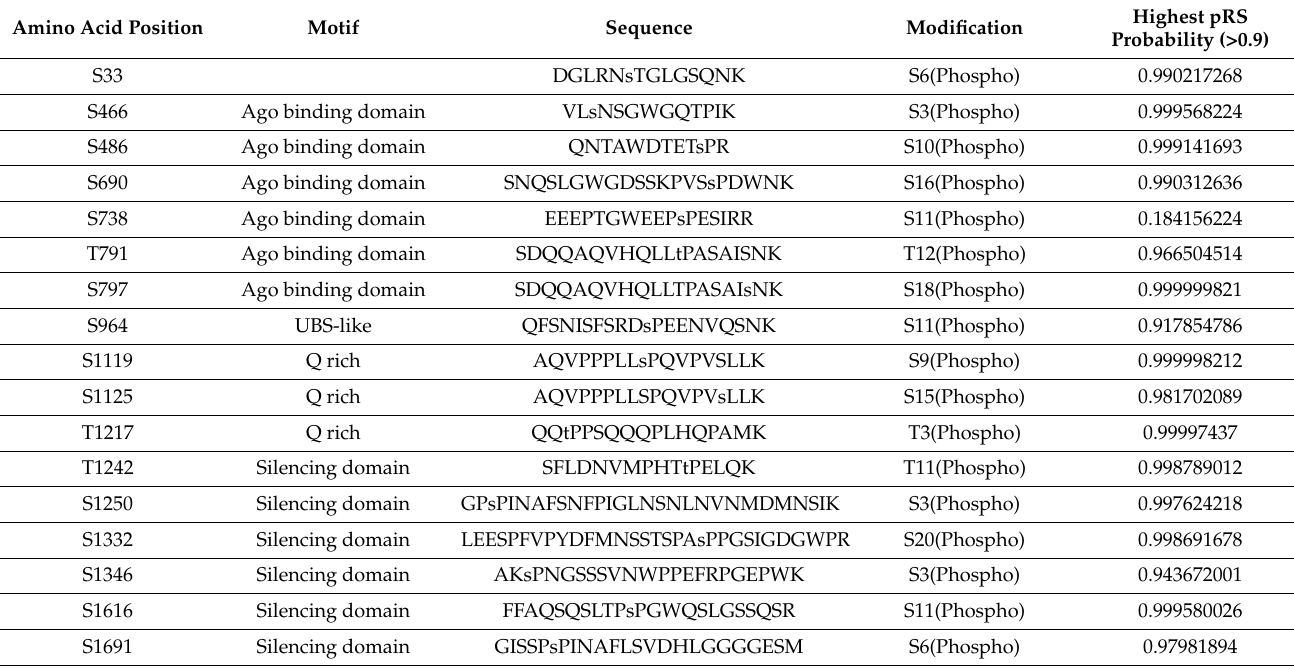
Table 2. Identified phosphorylation sites of TNRC6A in our previous